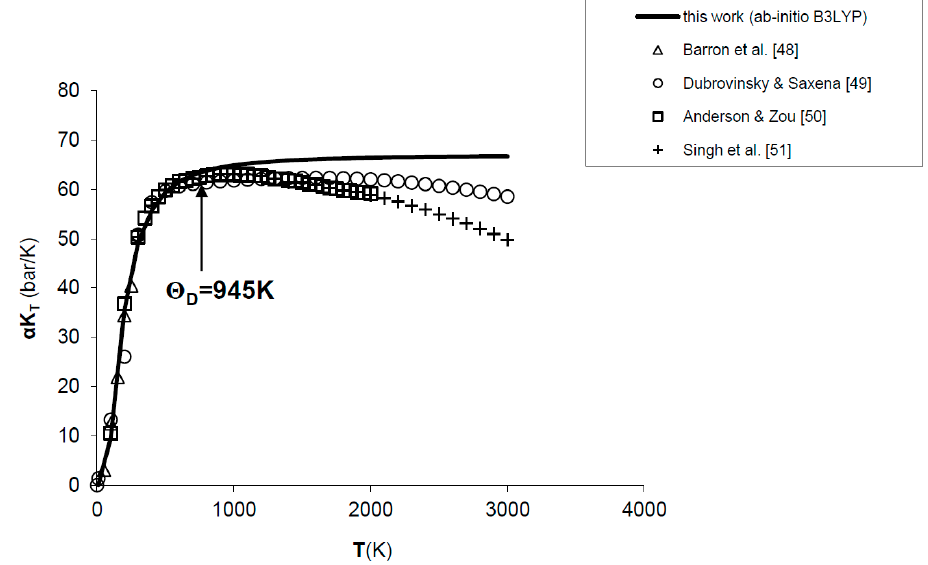
Figure 1. Ab initio B3LYP results for the product α K T of MgO, as compared to experimental data [48,49] and thermodynamic assessments [50,51]. Θ D = 945 K is the Debye